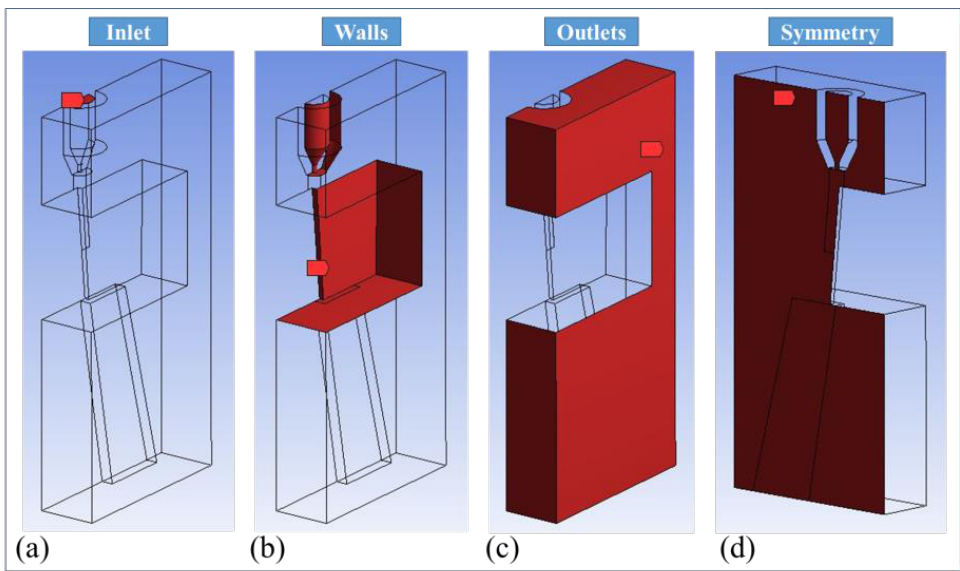
Figure 7. Computational domain showing boundary layers. ( a ) Inlet, ( b ) Walls, ( c ) Outlets, and ( d ) Symmetry.